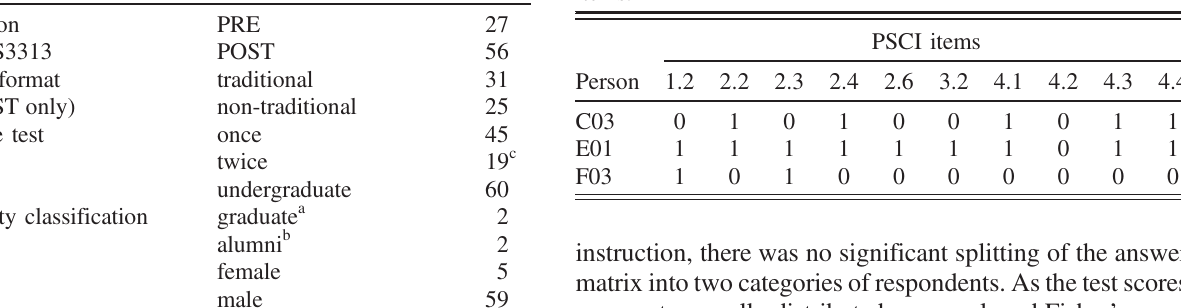
TABLE II. Person sample for the PSCI item calibration. TABLE III. Excerpt from answer matrix. Note that C03, E01, and F03 are codes for persons. 1.2, 2.2, etc., are codes for PSCI